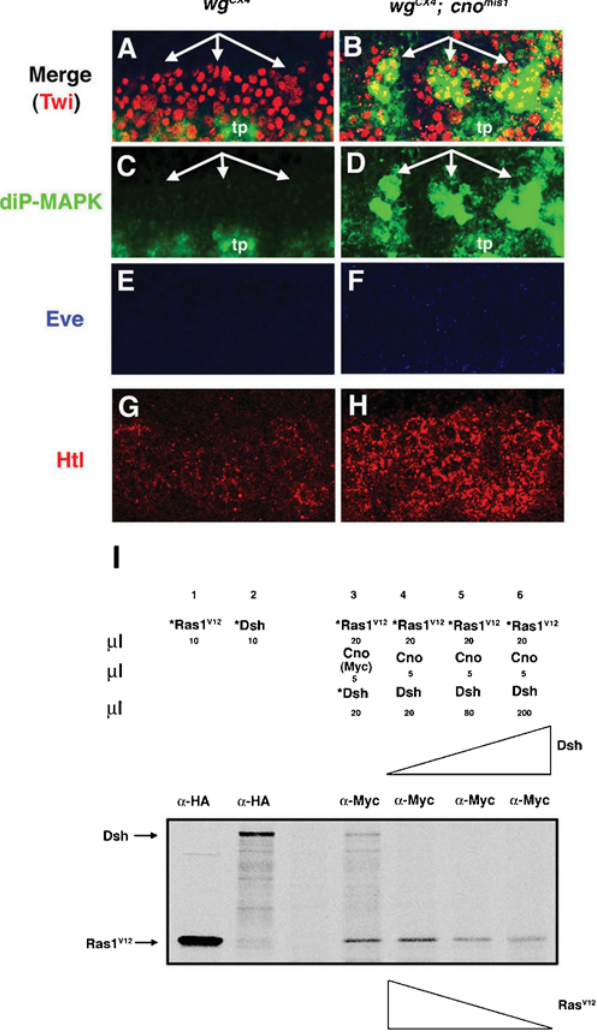
Figure 7. Wg-Dsh signaling releases Cno-mediated Ras repression. (A–H) Lateral views at high magnification (63 6 ) of stage 11 embryos showing three hemisegments. (A, C, E) In wg CX4 mutants neither diP- MAPK (green) nor Eve (blue) expression is detected in the mesoderm, which is marked by Twi (red). (G) The FGFR Htl (red) is also downregulated in wg CX4 mutants. (B, D, F, H) Both diP-MAPK (B, D) and Htl (H) expression are rescued in wg CX4 ; cno mis1 double mutants; Eve expression is not rescued (F). tp, tracheal pits. (I) Dsh competes with Ras for binding Cno. Proteins were translated in vitro in presence (*) or absence of 35 S-Methionine. Lane 1 and 2: *Ras V12 and *Dsh, both HA- tagged, were immunoprecipitated with an a -HA antibody (Ab). Lane 3: Both *Ras V12 and *Dsh were co-IP with Cno by an a -Myc Ab. Lane 4, 5 and 6: The addition of increasing amounts of Dsh leads to a decrease in the amount of *Ras V12 co-IP with Cno.